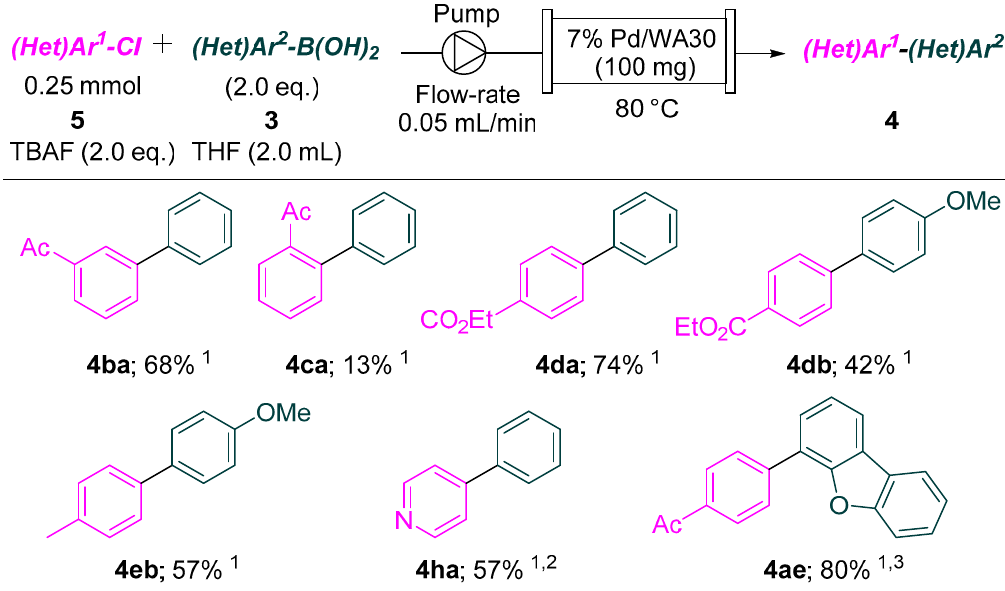
Figure 3. Scope of substrates of the 7% Pd/WA30-catalyzed continuous-flow Suzuki–Miyaura coupling reaction of (hetero)aryl chlorides with (hetero)aryl boronic acids.